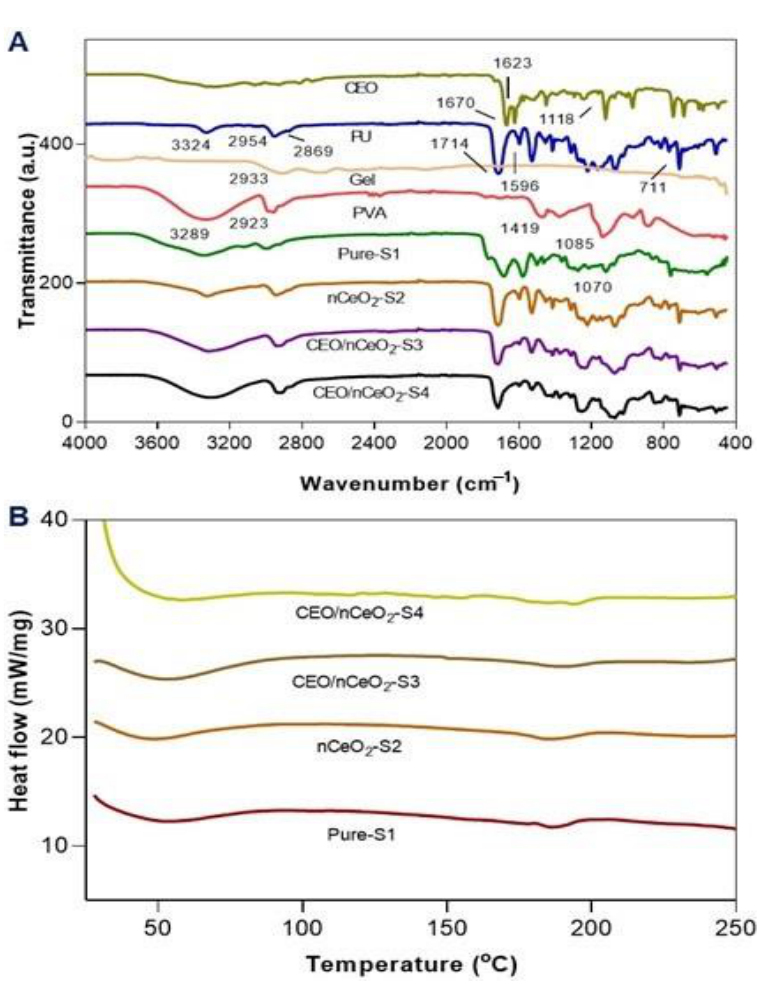
Figure 5. ( A ) FT-IR (4000-400 cm −1 ), and ( B ) DSC of the produced nanofibrous